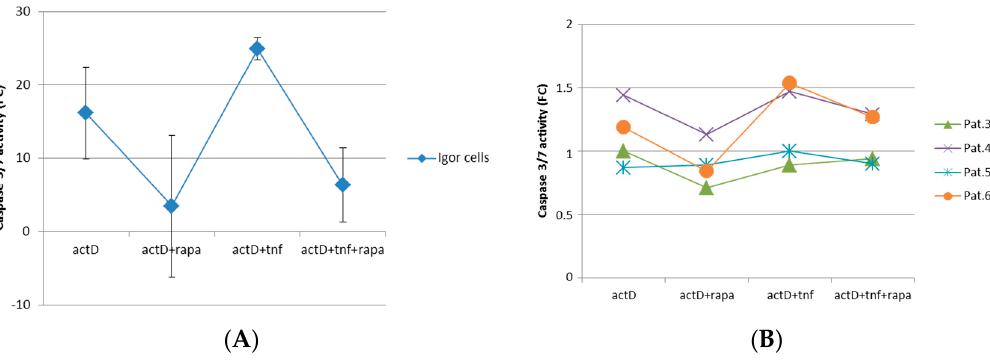
Figure 3. Caspase 3/7 assay of chondrocytes cultured in a monolayer under inflammatory conditions. To induce apoptosis, chondrocytes obtained from: healthy cartilage ( A ); and patient-derived OA chondrocytes ( B ) were cultured with the transcription inhibitor Actinomycin D. To mimic the inflammatory environment present in OA, chondrocytes were treated with tumor necrosis factor α (TNF- α ). To assess protective effect of mTORC1 inhibition on OA chondrocytes, cells were also treated with rapamycin. Experiments were performed in triplicates and results are shown as mean ± standard deviation (SD) was calculated for ( A